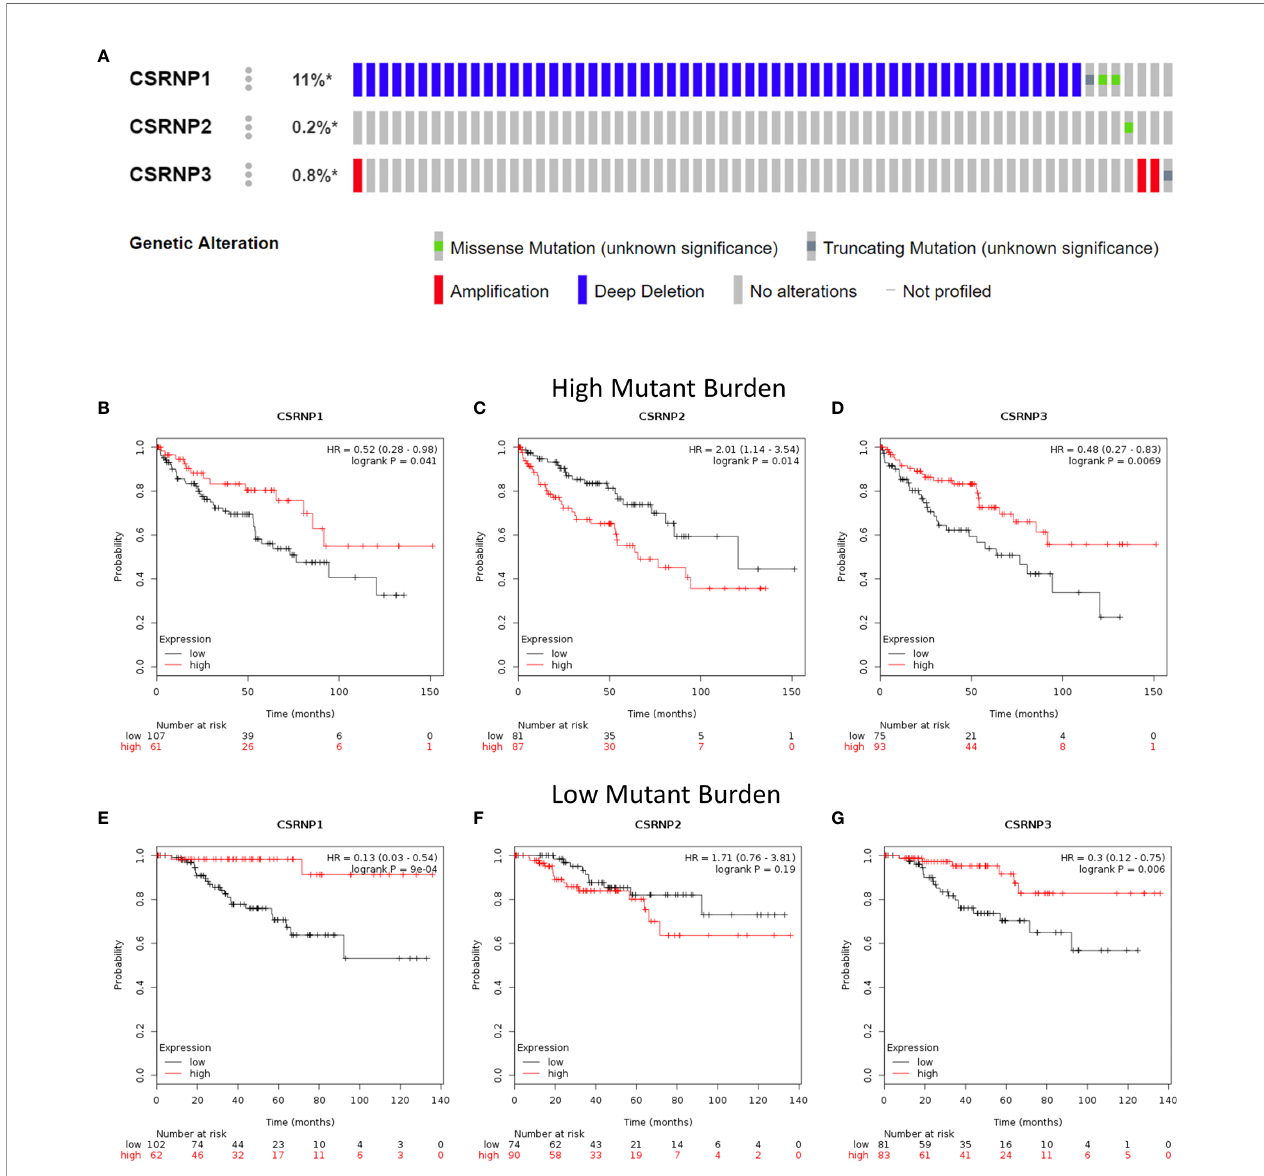
FIGURE 5 | Genetic alterations and overall survival in patients with high- and low-mutant burden within CSRNP family according to cBioPortal. (A) Genetic alterations of CSRNP genes in patients from TCGA dataset (each rectangle represents one patient; not all patients were shown [n = 532]); (B – G) Overall survival of patients with high- (B – D) and low- (E – G) mutant burden within CSRNP